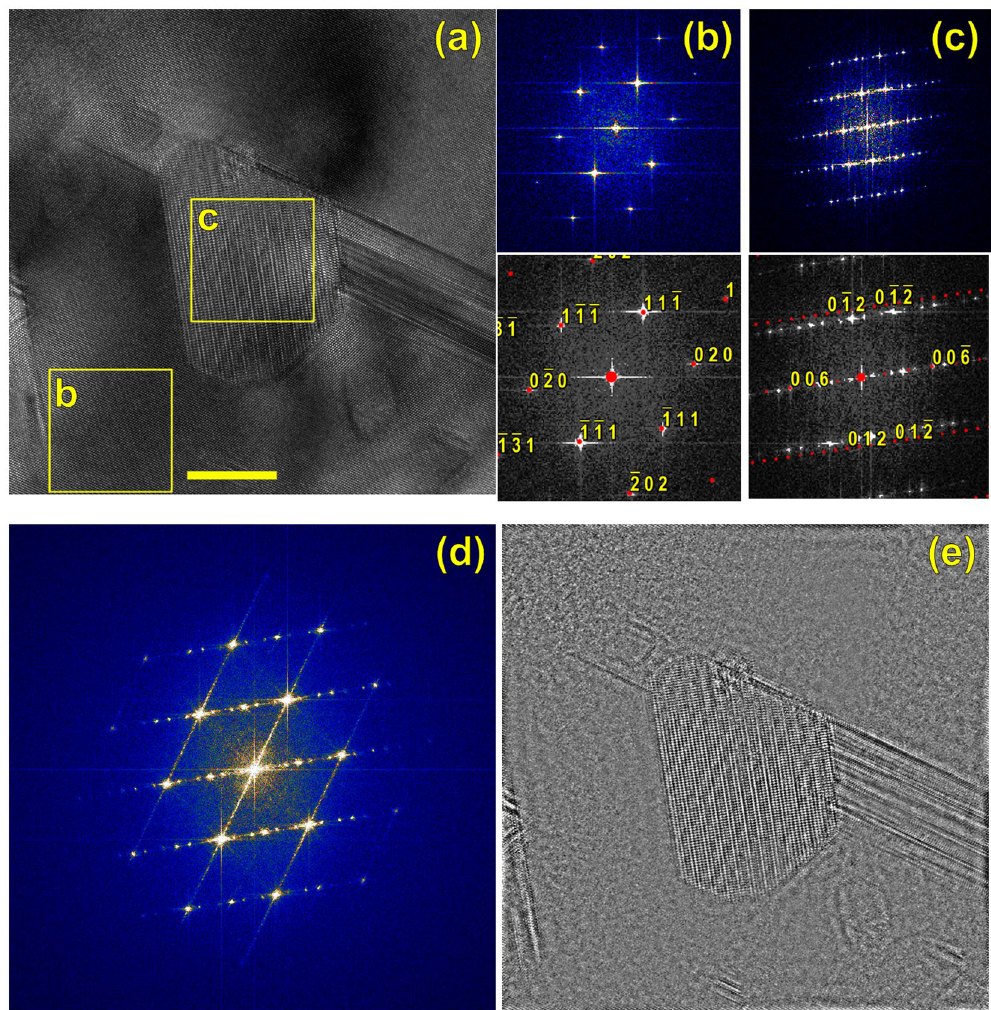
Figure 4. HRTEM image on the [101] matrix zone. Boxes marked “b” and “c” denotes the Fourier transforms of ( b ) and ( c ), which also show calculated diffraction patterns for 3C and 6H SiC. (The 6H pattern is not an exact match). ( d ) The Fourier transform of the entire image, showing dislocation streaks, cubic spots, and precipitate spots. ( e ) Inverse Fourier transform after the cubic spots were removed from ( d ); only the precipitates and dislocations remain. Scale bar 10